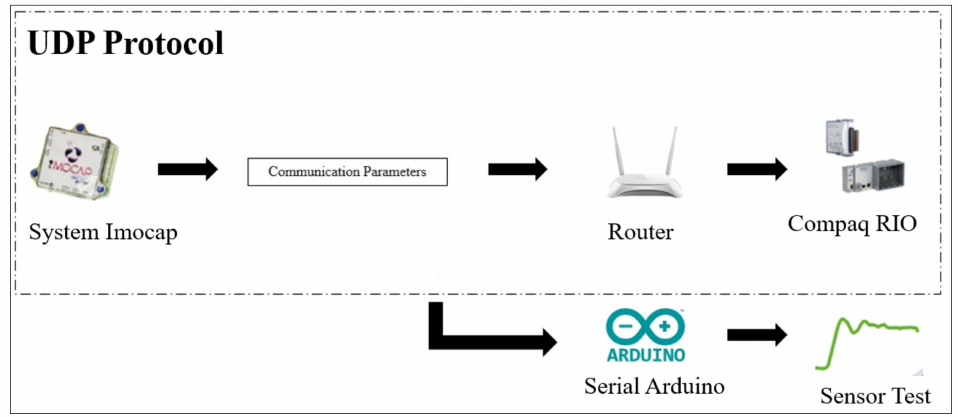
Figure 3. Connection diagram of the Imocap-GIS